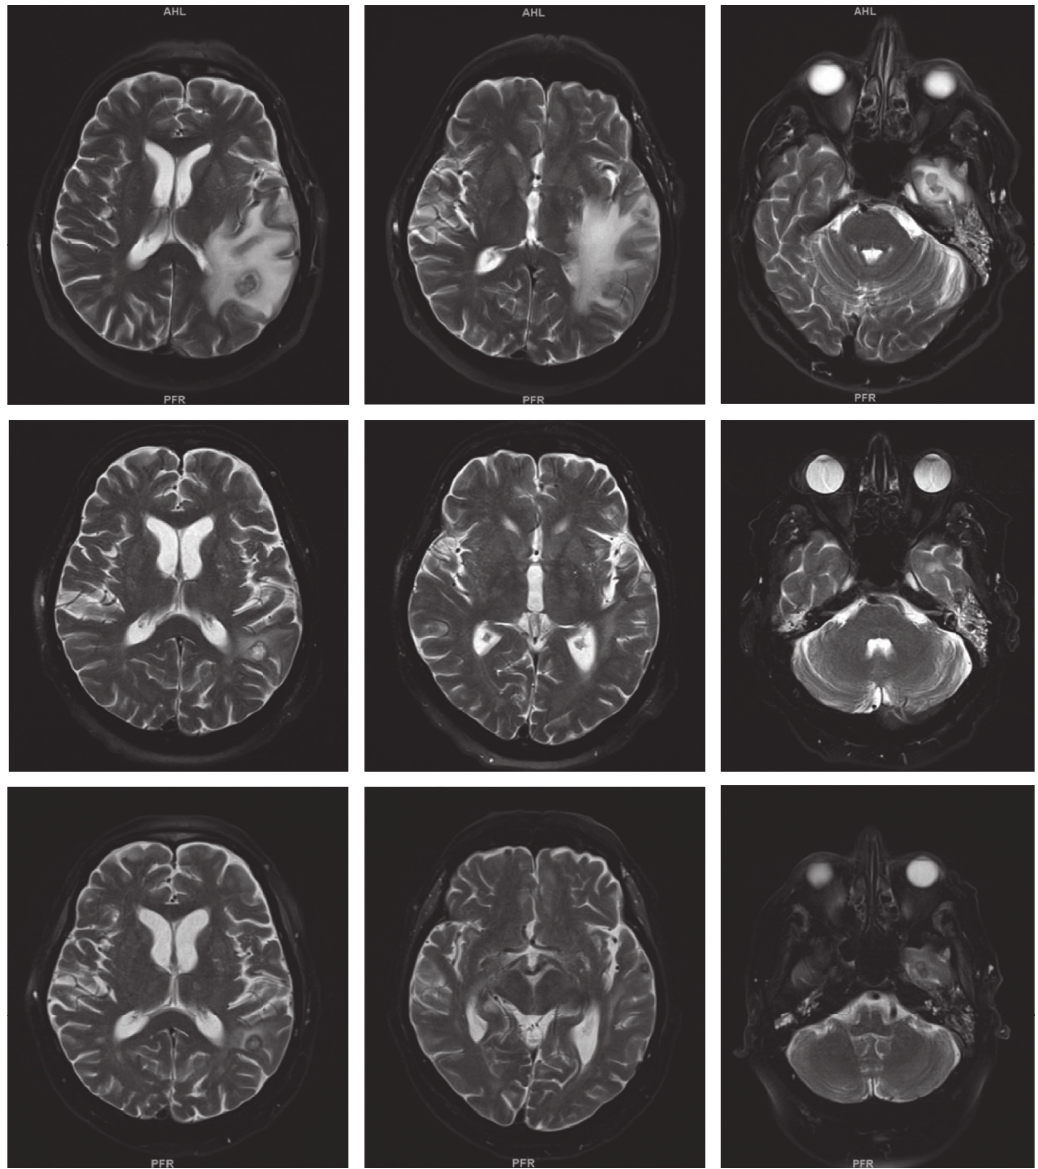
Figure 1: T2-weighted sequences of the brain MRI demonstrating cerebral abscesses and associated edema. Top row: initial presentation; middle row: repeat imaging, 3 weeks after initial presentation; bottom row: final imaging, 2 months after initial